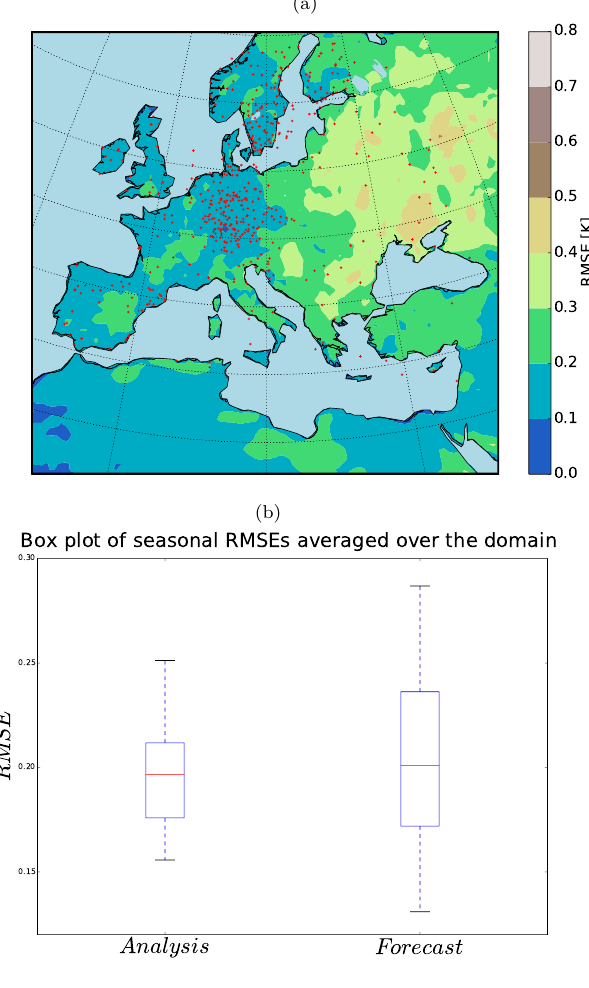
Figure 8. (a) 36-year RMSE (K) of the analysis for summer (JJA) and (b) the field mean RMSE (K) of the analysis and the free ensem- ble for summer (JJA). Red squares indicate the mean of RMSEs.